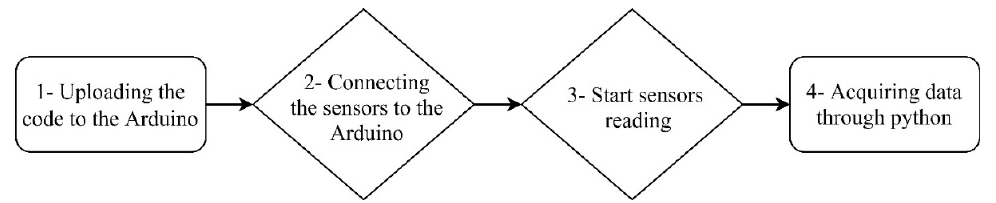
Figure 3. Diagram of needed steps for proposed kit data acquisition.